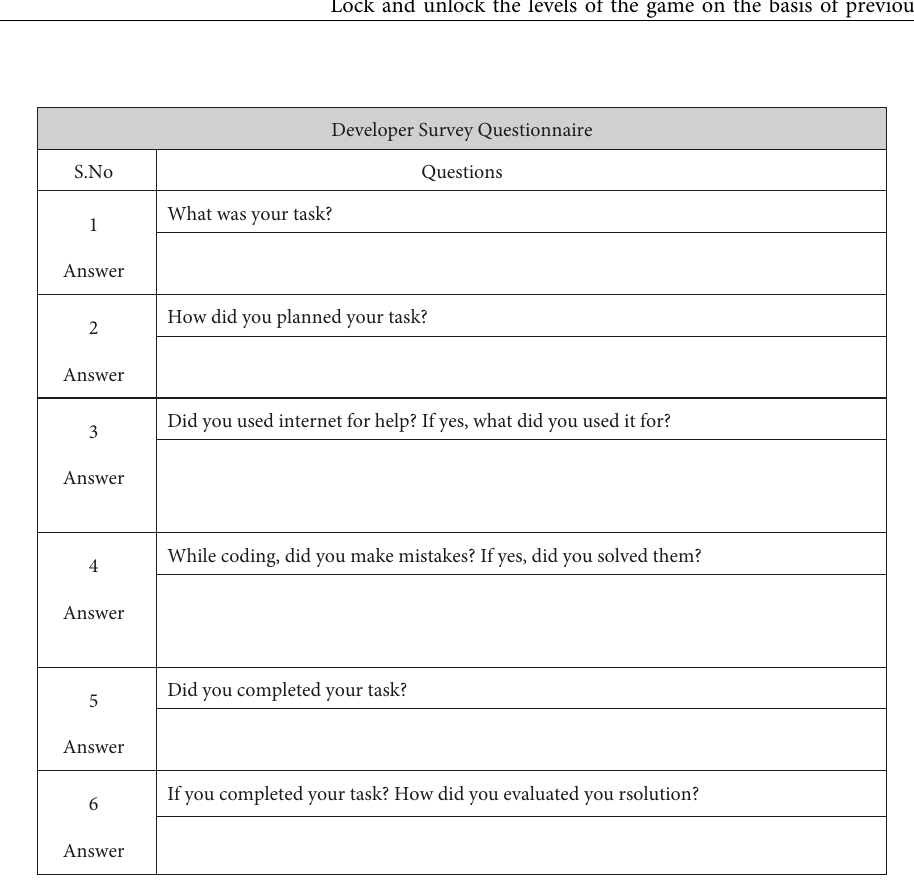
Figure 3: Self-assessment log.